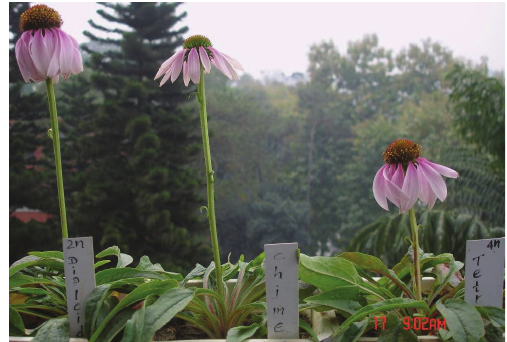
Figure 4: Mature diploid (left), chimeric (middle), and tetraploid (right) plants with